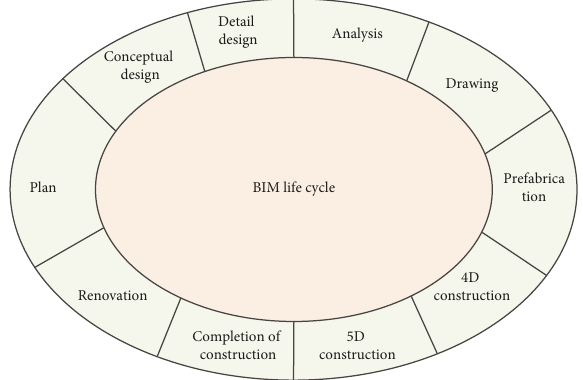
Figure 5: Seismic performance detection model based on BIM technology.